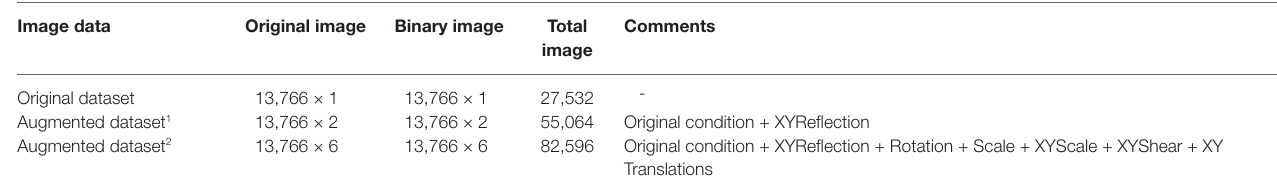
TABLE 6 | The image datasets for performance study and comparative